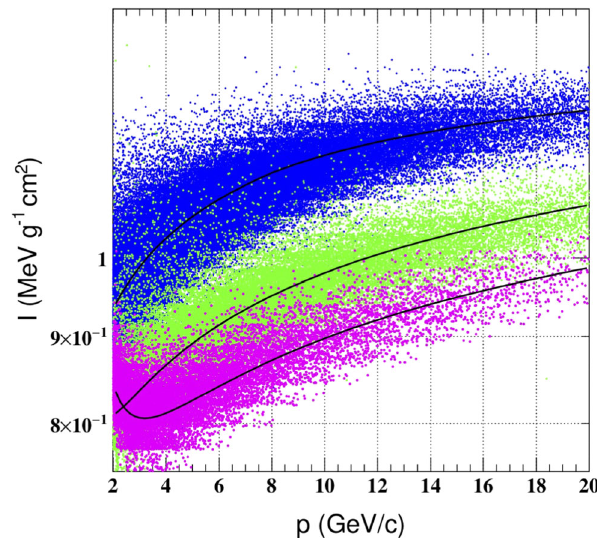
Fig. 1 The dependence of the truncated mean I of the track dE / dx , as a function of βγ (left) and p (right) for charged particles traversing the TPC of the CEPC detector. In the left plot the dots represent the